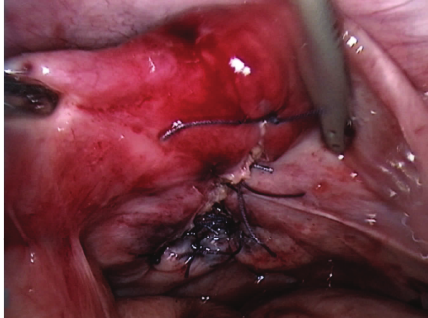
Figure 3: Laparoscopic repair of the defect involving Vicryl simple